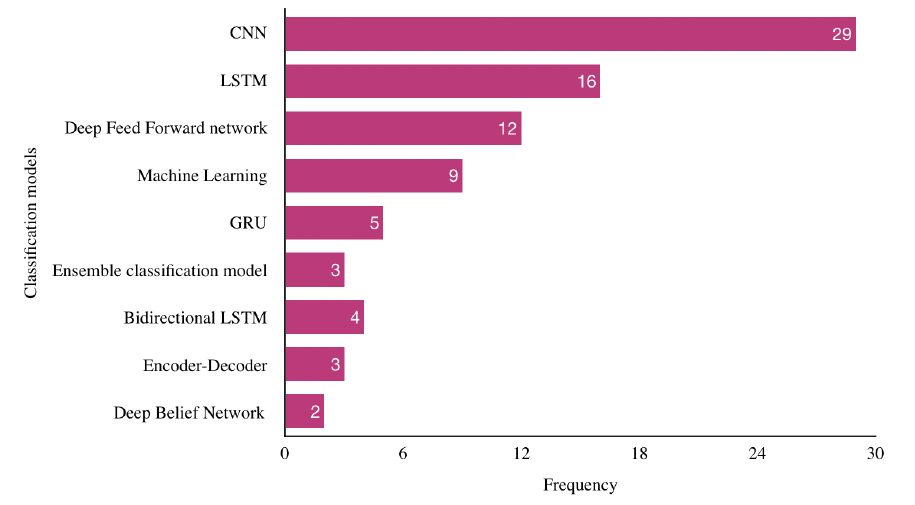
Figure 14. Histogram of classification models used in selected